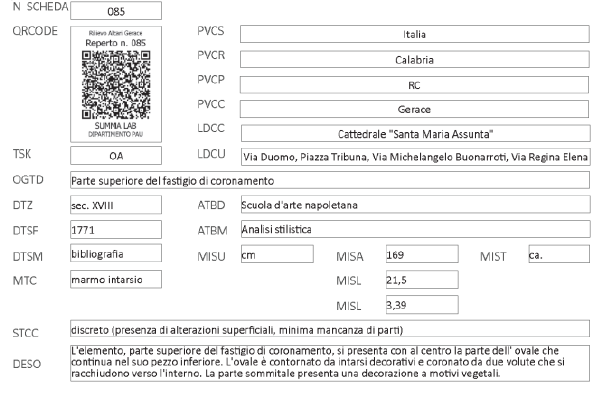
Figure 8. A detail of the catalog card.